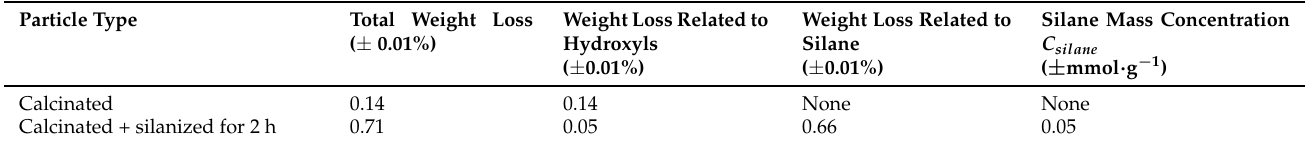
Table 2. TGA mass loss relative to the hydroxyls and silanes, for particles initially calcinated then silanized for 2 h, compared to strictly calcinated particles, and associated grafted silane mass